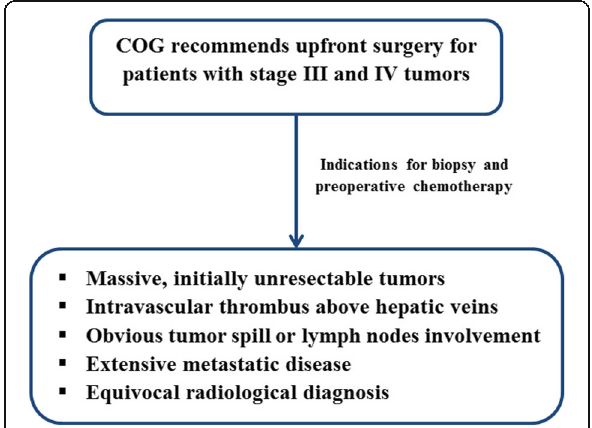
Fig. 1 Current COG recommendations regarding the timing